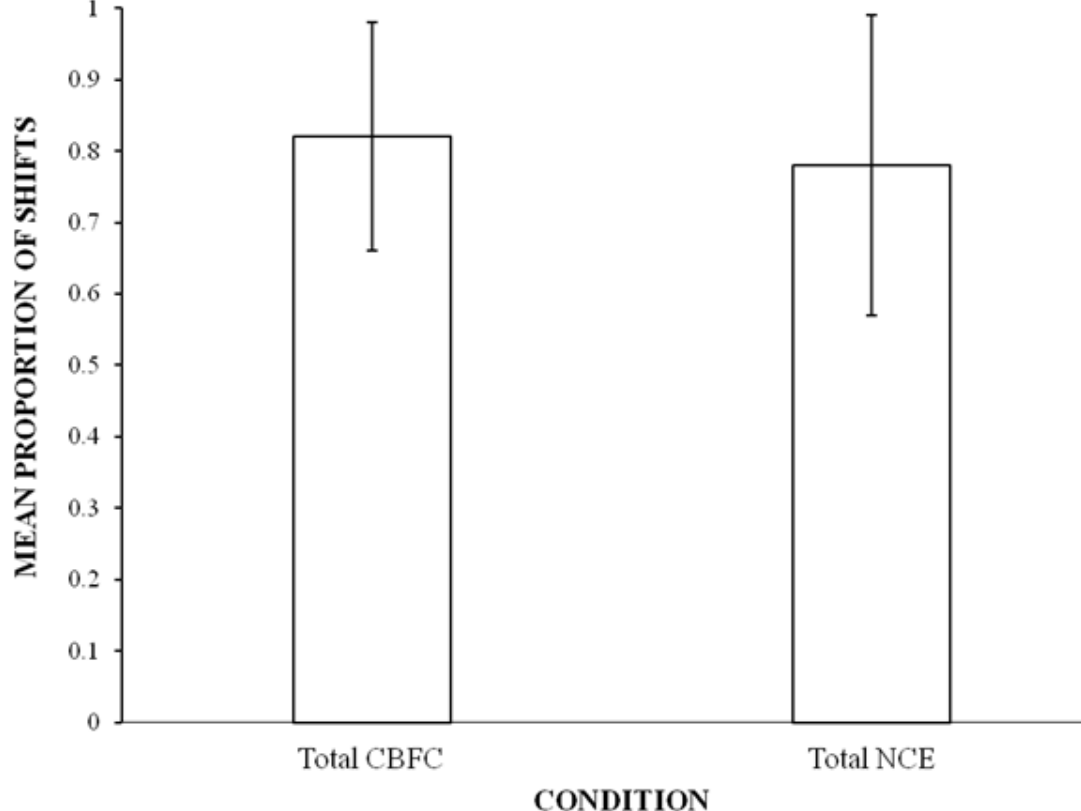
Figure 2 . The mean proportion of overall shifts for Stage 2. There was a non-significant tendency between chimpanzee based food calls (CBFC) and total name calling and encouragements (NCE), p = 0.093 (non-significant tendency), Wilcoxon matched-pairs signed-rank